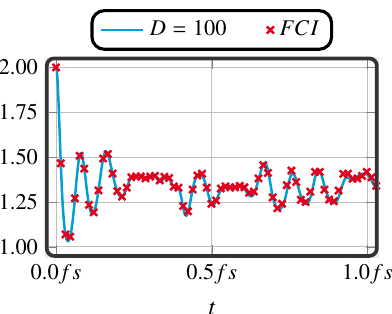
Figure 1: Occupation number of the HOMO-3 or- bital (solid line, left axis) and relative error of the two electron reduced density matrix (dashed line, right axis) of H 10 .